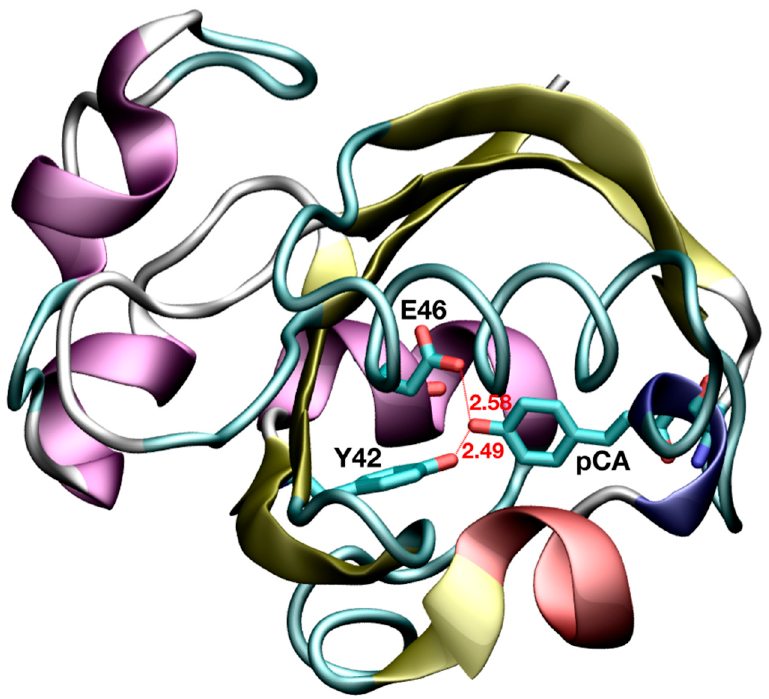
Figure 1. Short hydrogen bond interactions between active site residues and the photoactive yellow protein (PYP) chromophore. Distances are given in Å.